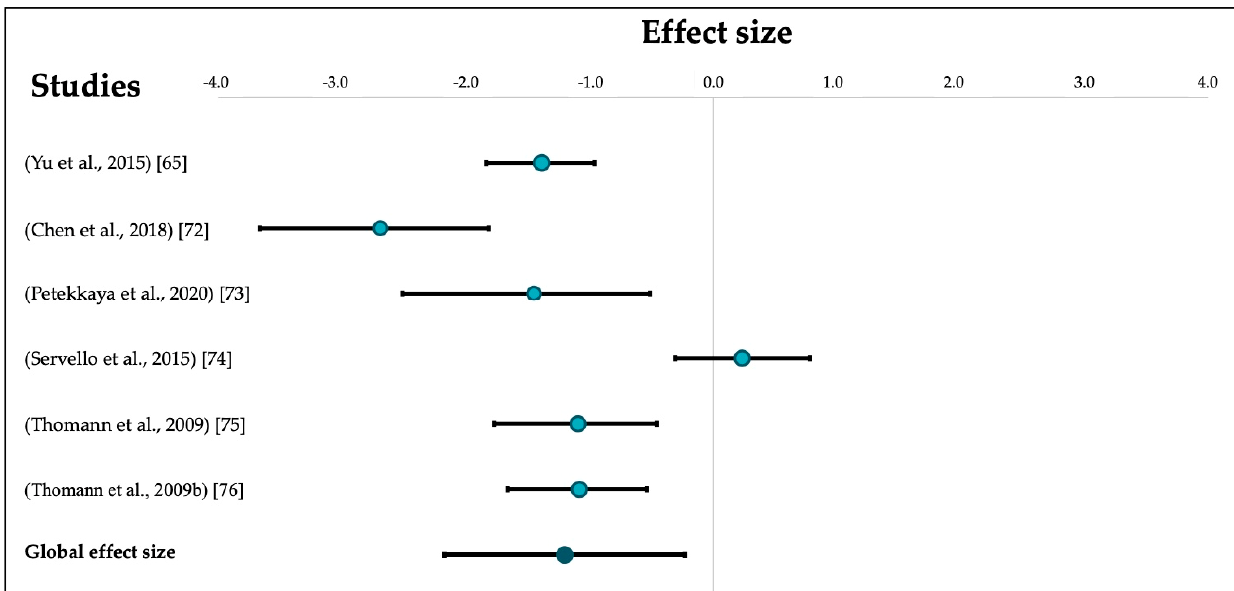
Figure 2. Forest plot of effects sizes for OB volumetric comparisons between patients with AD and controls. Error bars represent 95% CIs. Table 2. Characteristics of studies including patients with MCI in the meta-analysis on